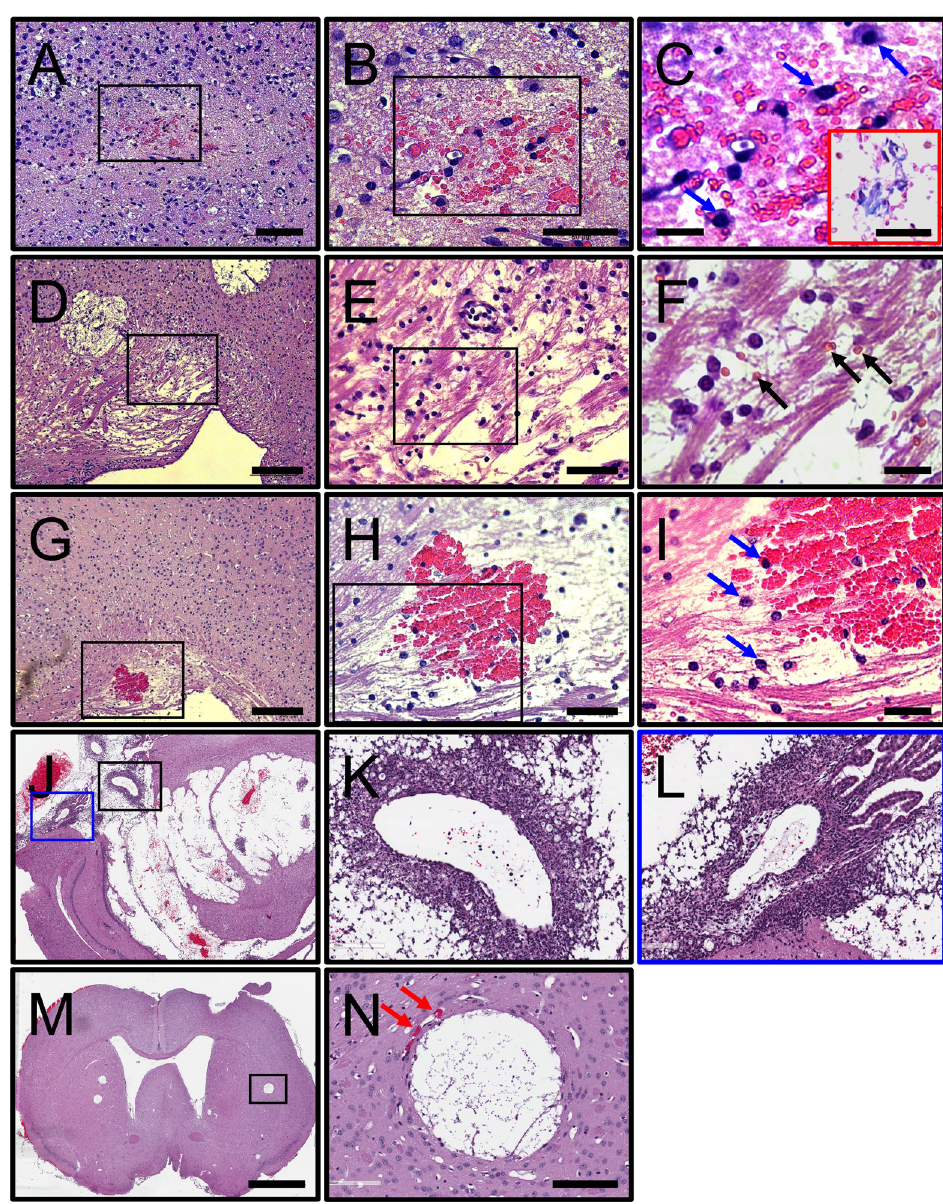
Fig 9. C . neoformans infection causes microinfarctions and hemorrhage in cerebral tissue. (A-B) Hemorrhagic microinfarction (black rectangles) in the frontal cortex and (C) infiltration of gitter cells (blue arrows) from microglia origin 7-dpi. Black rectangles in A and B correspond to a magnified region of the tissue shown in the right-side panel. Scale bars: (A) 100 μ m, (B) 60 μ m, and (C) 20 μ m. Red inset exhibit Prussian blue staining to confirm that hemosiderosis or focal deposition of iron due to local bleeding Scale bar: 10 μ m. (D) Leukomalacia or necrosis of white matter near a cryptococcal lesion in the corpus callosum. (E-F) Magnified region in D exhibits demyelination of the nerve fibers, recruitment of gitter cells, and the presence of erythrocytes (black arrows). Scale bars: (D) 200 μ m, (E) 50 μ m, and (F) 20 μ m. (G-I) Extensive bleeding, degeneration of nerve fibers, and gitter cell infiltration (blue arrows) in the corpus callosum. Scale bars: (D) 200 μ m, (E) 50 μ m, and (F) 20 μ m. (J) i.c. C . neoformans infection of the striatum results in extensive encephalomalacia, multiple hemorrhage foci, and (K-L) considerable aggregation of polymorphonuclear cells around the blood vessels and in the lesion. (K) Black and (L) blue boxes in J are magnification of those regions. (M) Coronal section at the level of anterior commissure in the right ventricle of mice infected with C . neoformans . Scale bar: 1 mm. (N) Magnification of a cryptococcoma (black rectangle box) showing microthrombus in the wall of blood capillary, resulting in microinfarctions (red arrows). Scale bar: 200 μ m.